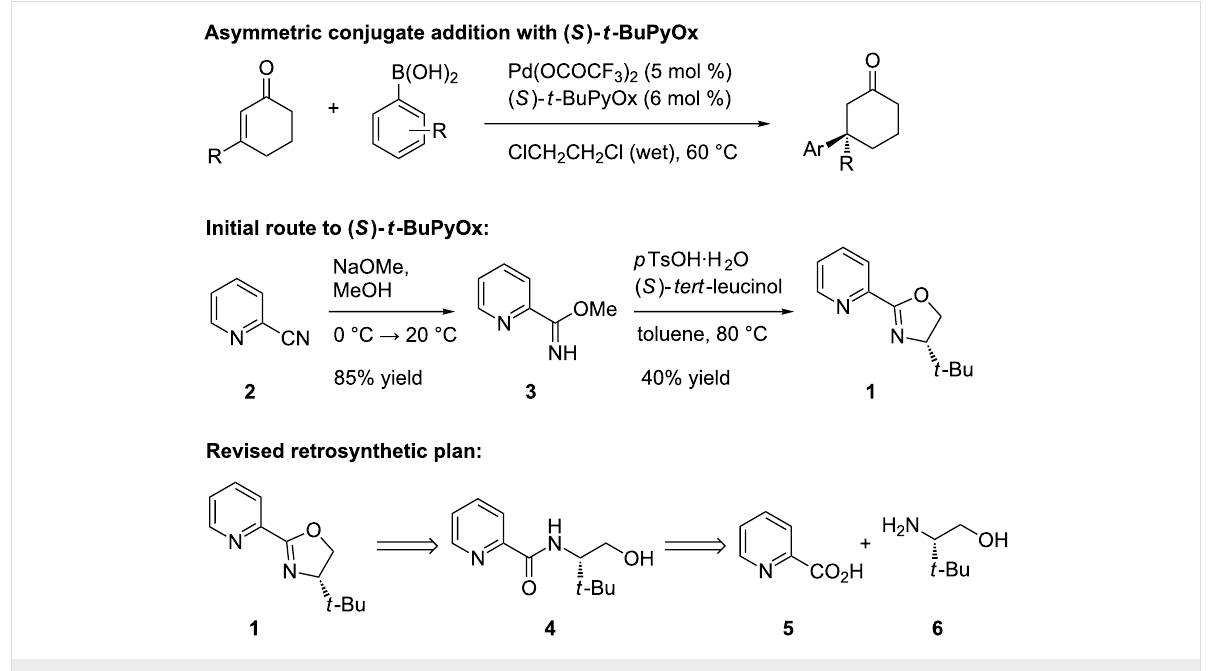
Figure 1: Initial PyOx synthesis and revised plan.